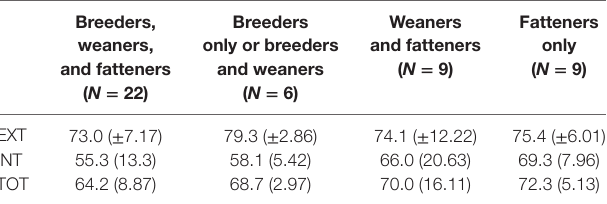
TaBle 8 | Mean and SD of internal (INT), external (EXT), and total (TOT) biosecurity scores for the different types of farm. Breeders,